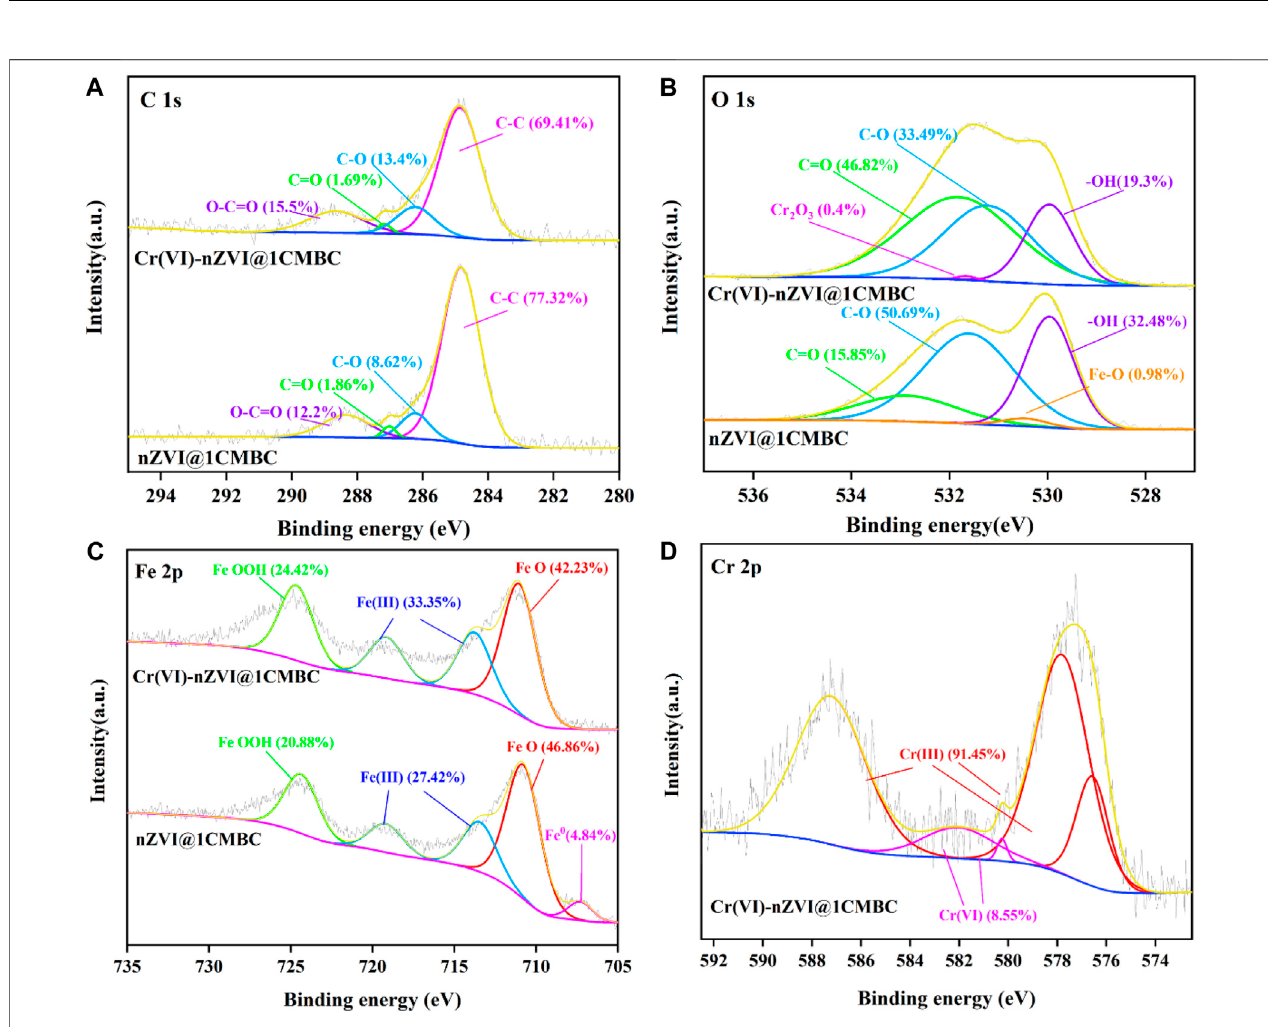
FIGURE 6 | XPS spectra of nZVI@1CMBC and Cr(VI)-nZVI@1CMBC. C1s (A) , O1s (B) , Fe2p (C) , and Cr2p (D) .